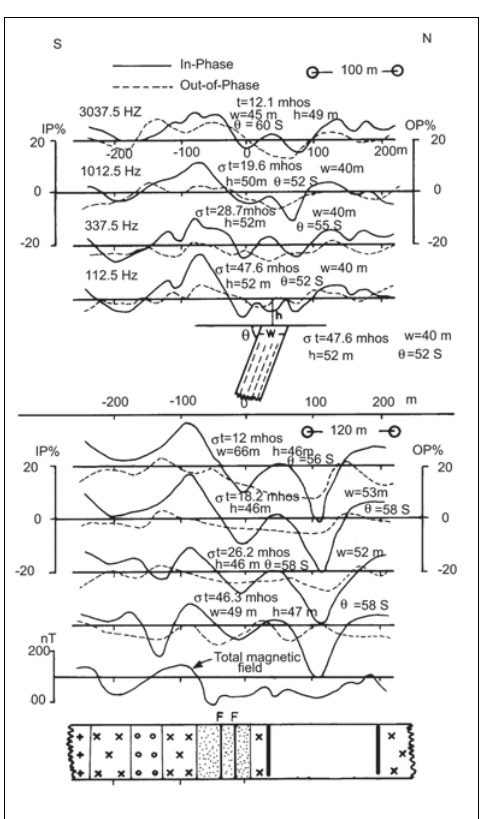
Fig. 8. Horizontal-loop EM profiles at several fre- quencies, coil separations and station separations with the corresponding total magnetic field profile along line A-A ′ (line 200) and surface geology of the Abu- Shihat radioactive prospect area, North Eastern Desert, Egypt. Symbols as in fig.